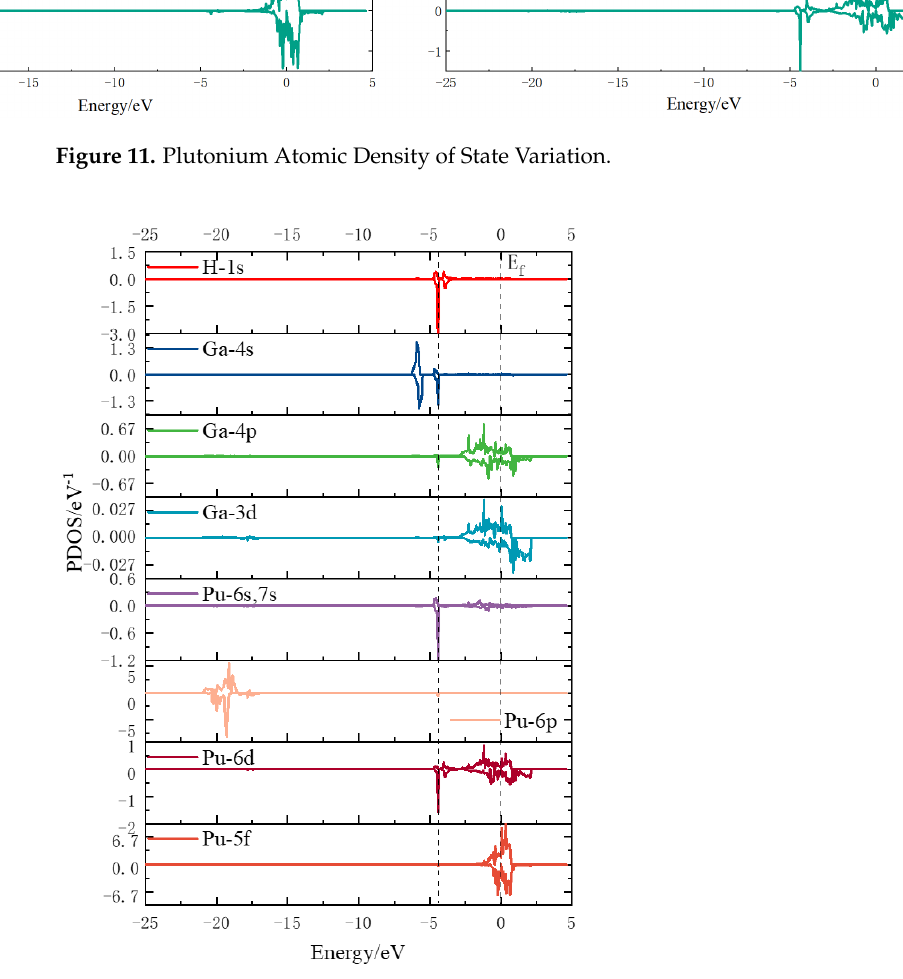
Figure 12. Density of fractional wave states after dissociation of hydrogen molecules.